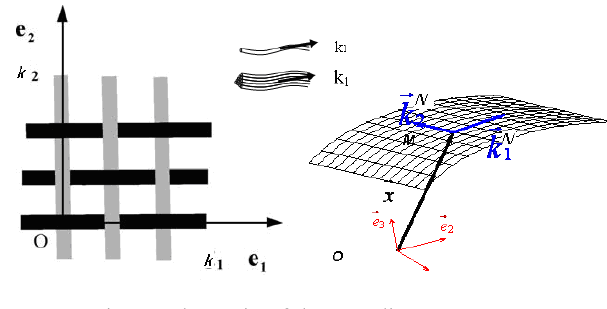
2: Schematic of the coordinate